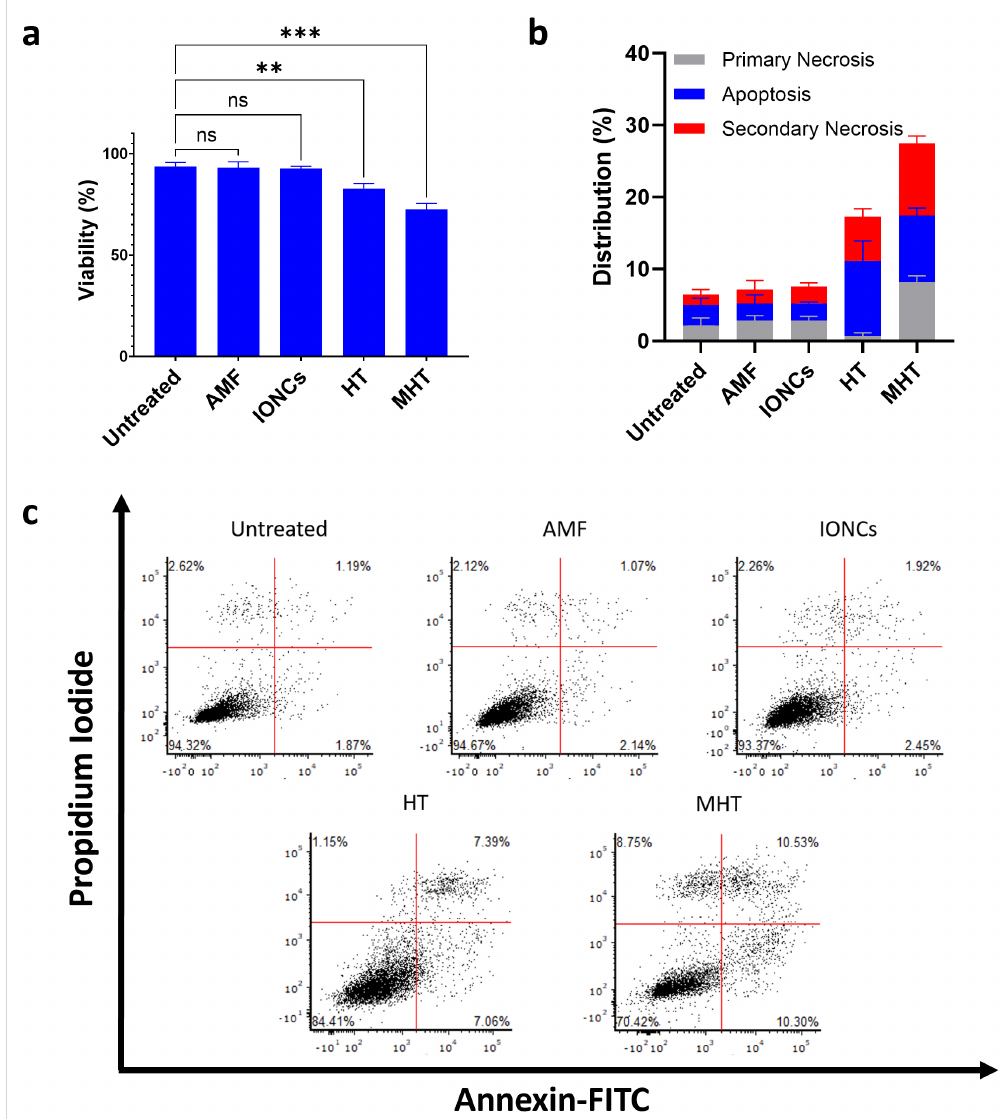
Figure 2. Evaluation of the ability of mild MHT to induce cell death in U87 cells measured using Annexin V/PI assay. MHT induces reduction of cell viability in U87 ( a ). After being exposed to mild MHT (3 cycles of 30 min at 43 ◦ C), U87 cells were left to rest for 24h and then stained with annexin-V-FITC and PI. Frequency of apoptotic (Annexin V + /PI − ) (blue bars), primary necrotic (Annexin V - /PI + ) (grey bars) and secondary necrotic (Annexin V + /PI + ) (red bars) U87 cells were determined via flow cytometry ( b , c ). Data are represented as mean ± SD of three independent experiments ( n = 3) ( b ). Representative dot plots of Annexin V/PI staining of U87 cells treated with AMF only (AMF), IONCs only (IONCs), heat bath at 43 ◦ C (HT) or IONCs + AMF (MHT) ( c ). Statistical significance was determined with a two − tail unpaired student’s t test (** 0.001 < p < 0.01; *** p < 0.001; n.s. = not